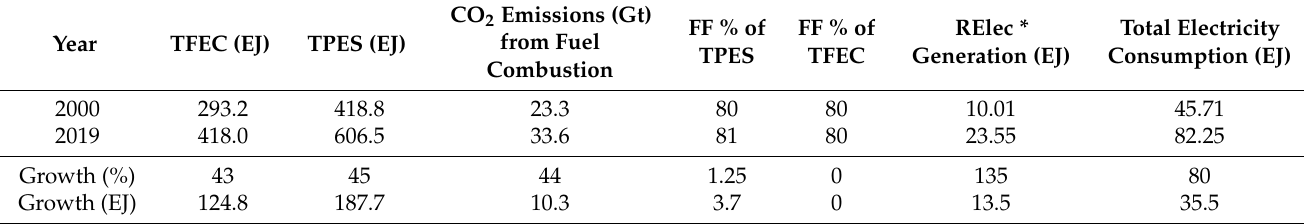
Table 1. Global TPES, TFEC and energy-related CO 2 emissions, 2000–2019.